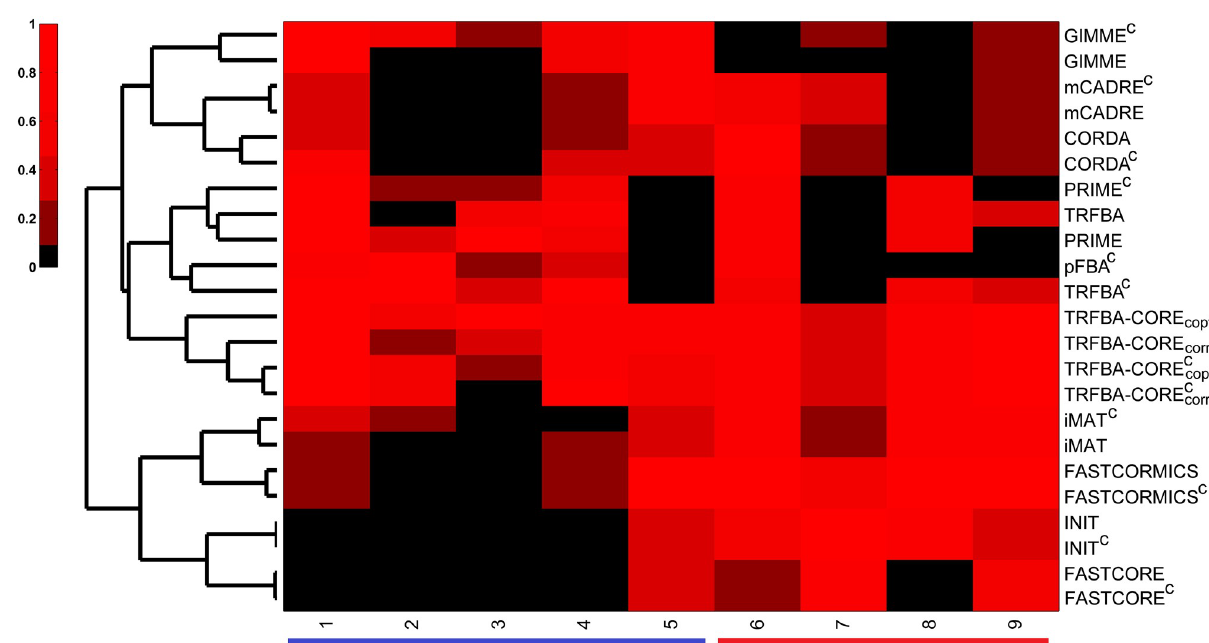
Fig 13. Hierarchical clustering of TRFBA-CORE performance scores. Hierarchical clustering (Euclidean distance) of the scores TRFBA-CORE received in different benchmarks. Despite being a GEM extraction approach, TRFBA-CORE was clustered with algorithms that do not trim the input model. TRFBA-CORE scores were generally higher in comparison benchmarks. Numbers in column correspond to comparison (blue color) or consistency (red color) benchmarks: 1-growth rate, 2- metabolite uptake/secretion rates, 3- drug response, 4- essential genes, 5- enrichment of OG/TS/ LOFs, 6- fraction of blocked reactions, 7- resolution power, 8- robustness to missing data, and 9- robustness to noise. Colorbar indicates normalized performance scores.